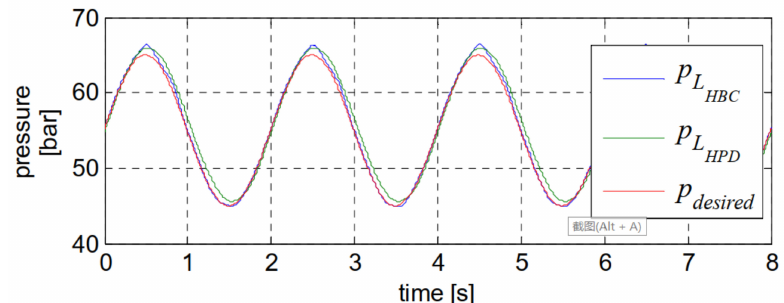
Figure 22. Measured accumulator pressures of an HBC and hydraulic proportional control for the periodic charging and discharging of a hydraulic accumulator.